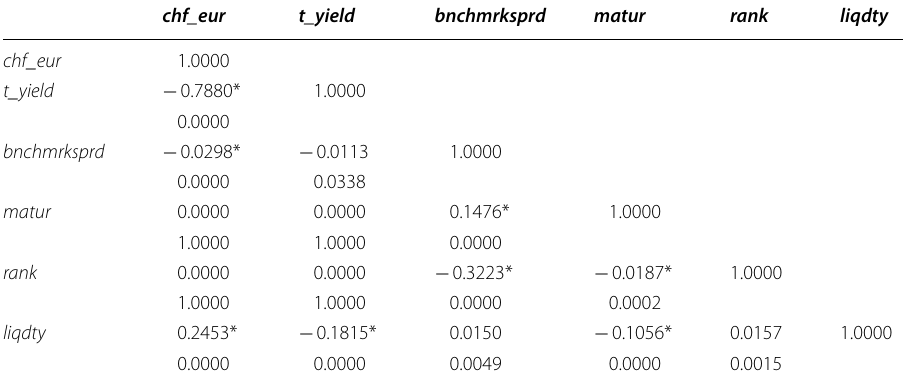
Table 2 Correlations results